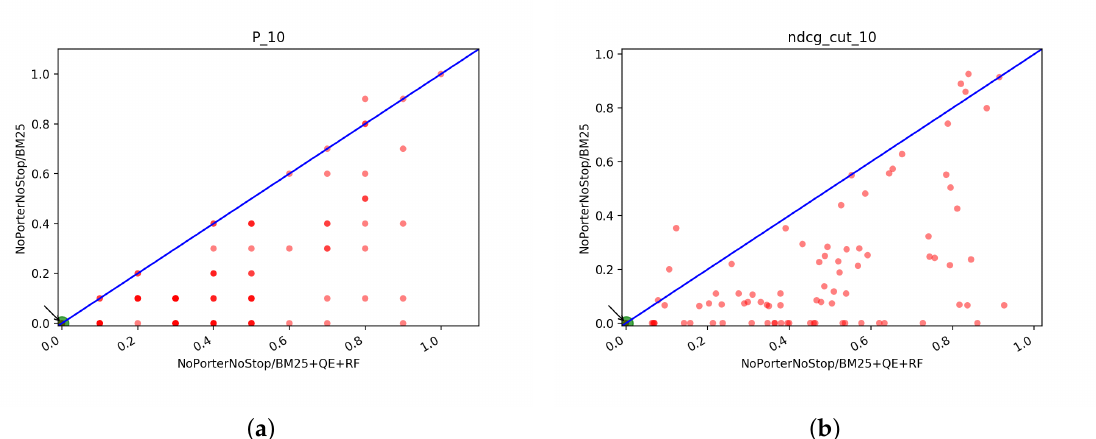
Figure 18. Scatter plots of NoPorterNoStop/BM25 with QE+RF vs. the same run without QE+RF: ( a ) P@10, ( b ) NDCG@10. Table 18. BM25 + QE + RF run vs. BM25 without QE+RF scores. Measure Mdpt # Of Outscored Topics N/B+QE+RF vs.